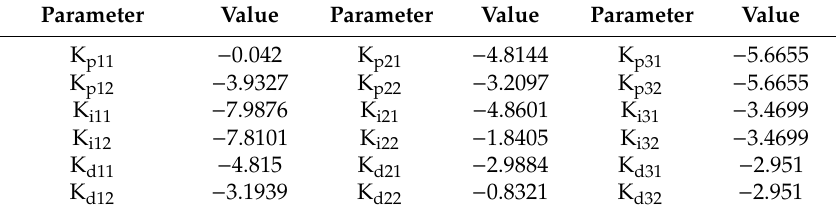
Figure 17. Performance of the convergence curve using the imperialist competitive algorithm (ICA). The optimal values are given in Table 5. Table 5. Optimal control parameter values.